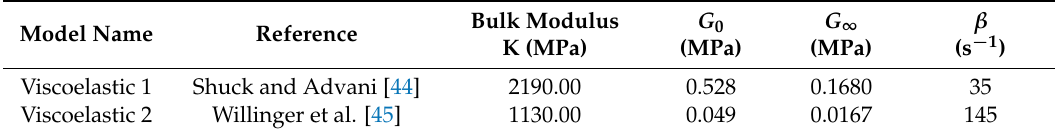
Table 3. Values of individual coefficients used in the current study.